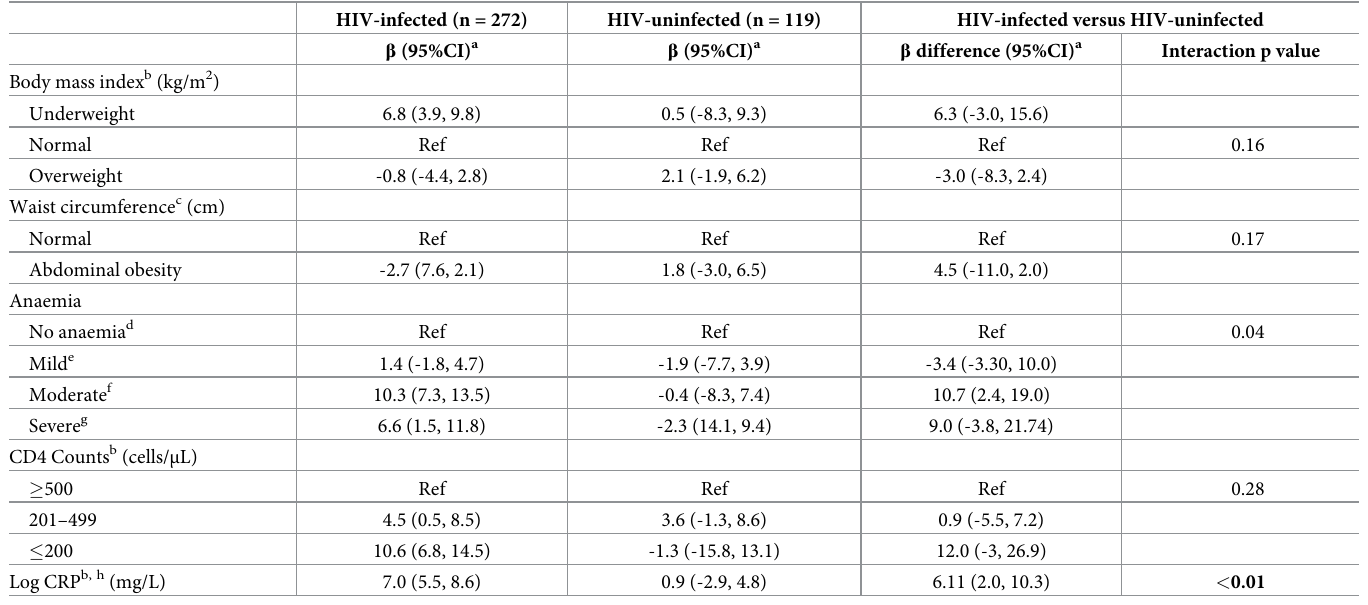
Table 3. Correlates of sleeping heart rate (beats/min) among HIV-infected and HIV-uninfected